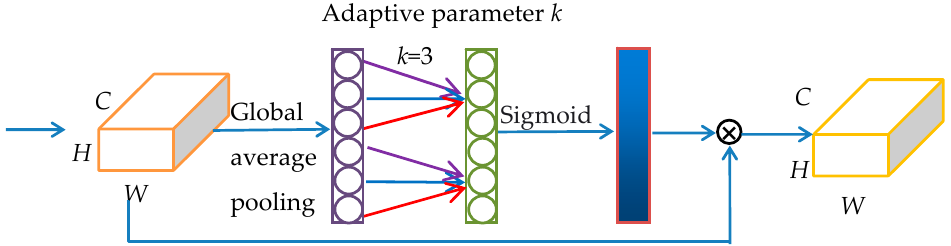
8 of 20 Figure 8. NAS FPN fusion process. 3.2. Channel Attention Module (ECA) In recent years, attention mechanism models inspired by human visual attention have been developing continuously. Implementing attention techniques in neural net- works helps the network focus on the essential parts of a problem, maximizing accuracy and efficiency [24]. The large-scale background interference in remote sensing images brings great challenges to target detection [25]. Adding an attention model can improve the robustness of the model against interference and the positioning accuracy of ship tar- gets. In this paper, a lightweight channel attention mechanism module ECA [26] without dimensionality reduction is added to the model. The structure of the ECA module is